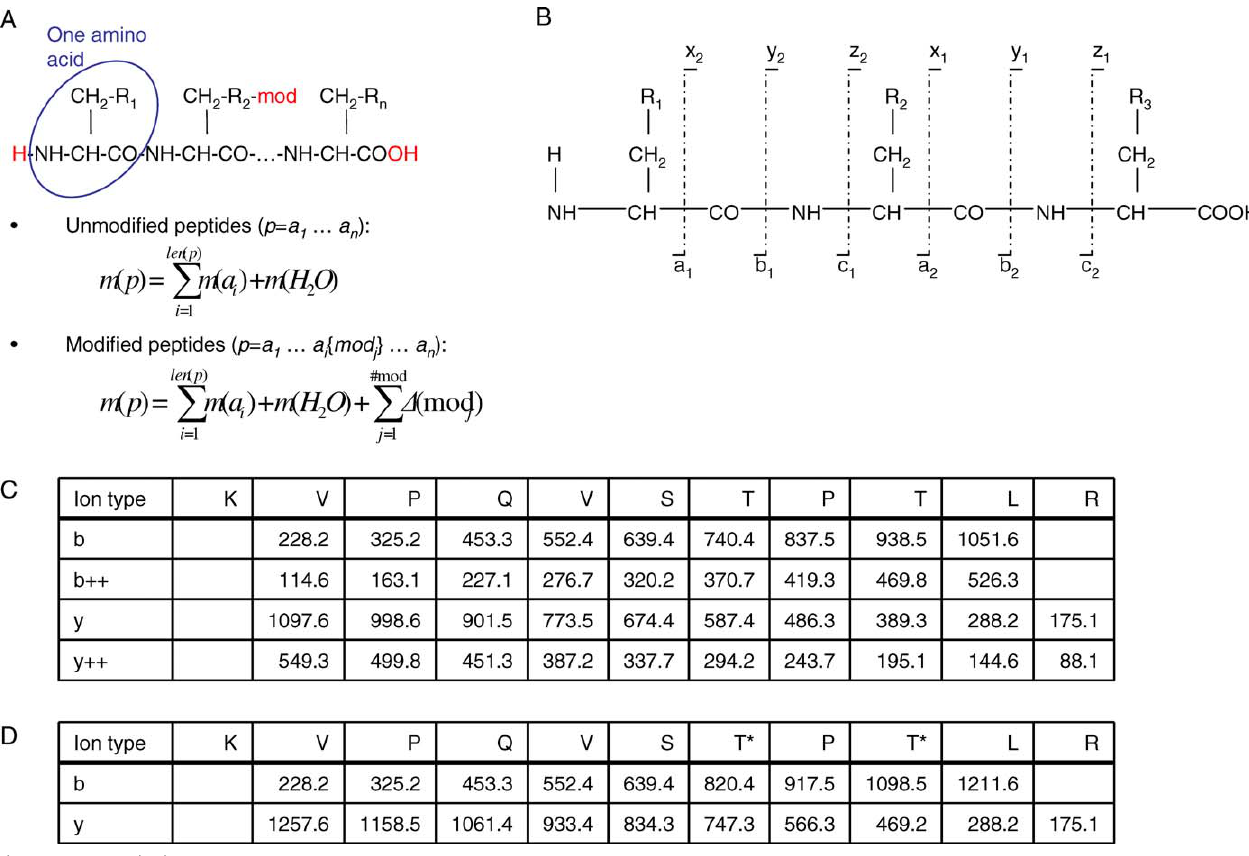
Figure 4. Peptide Theoretical Mass Computation and Fragmentation (A) As illustrated, the peptide atomic composition is dependent on the residue R i and on fixed atoms (H 2 O). Therefore, once the peptide sequence is known, it is possible to sum the mass of each amino acid and add the mass of a water molecule to determine the theoretical mass of the peptide. If some amino acid residues are modified, mass shifts are added to the unmodified peptide mass. (B) Peptides fragment at specific locations named a,b,c,x,y,z. N-terminal fragments are termed a i ,b i ,c i , where i denotes the number of amino acids in the fragment. Similarly, the complementary C-terminal fragments are termed x n (cid:2) 1 ,y n (cid:2) 1 ,z n (cid:2) 1 , n is the peptide length. (C) Example of fragment mass computation. (D) The same example as in (C) with phosphorylated threonine residues ( þ 79.9663 Da). Note that all fragment ions including the ion with one or two threonine residues are shifted in mass once or twice,